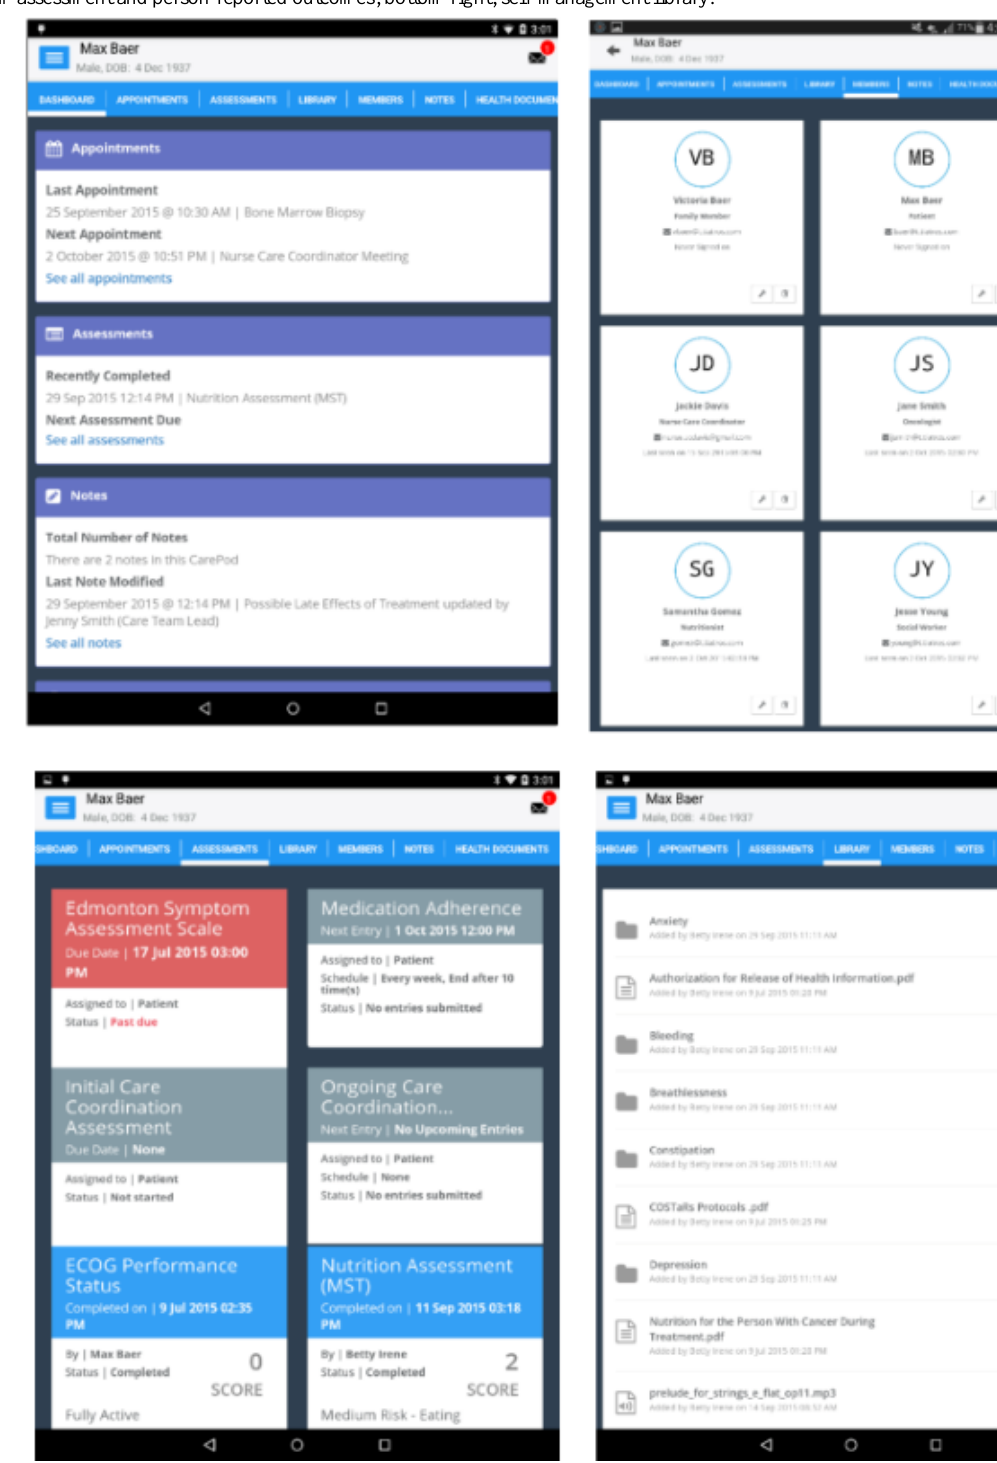
Figure 1. The Personal Health Network app, top left, dashboard, top right, care team including health professionals and family caregivers, bottom left, symptom assessment and person-reported outcomes, bottom right, self-management library.